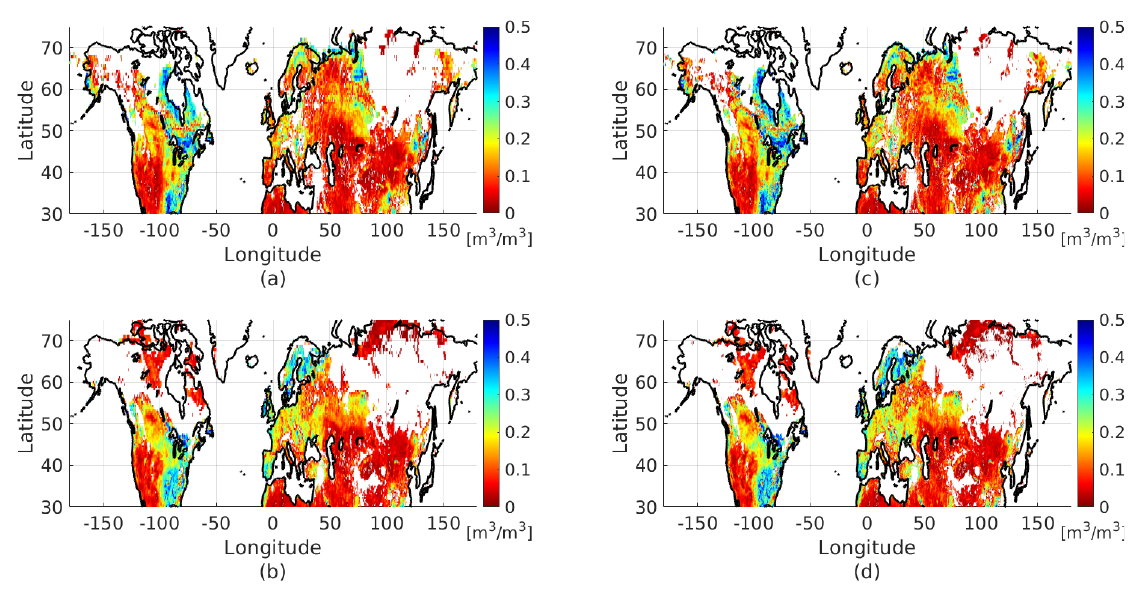
Figure 1. Soil Moisture and Ocean Salinity (SMOS)-derived Soil Moisture (SM) from [40] projected on a 36 km Equal-Area Scalable Earth (EASE) grid on ( a ) 15 October 2020 and ( b ) 5 November 2020, respectively, and and on a 9 km grid on ( c )